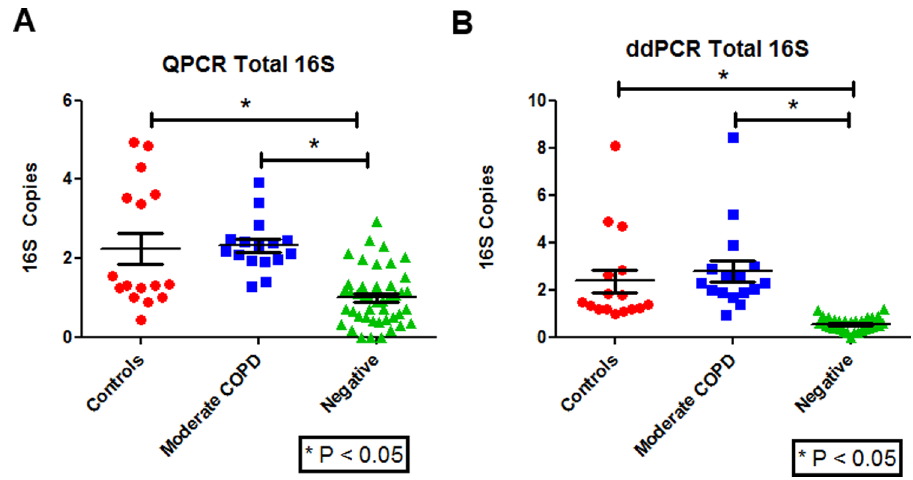
Figure 1. Overall total bacterial 16S load measured in lung tissue using qPCR or ddPCR. A) qPCR results in controls, moderate COPD, and negative non-template controls (water negative). The total bacterial 16S load was significantly lower in negative controls compared with moderate COPD and control lung tissue. B) ddPCR results in controls, moderate COPD, and negative non-template controls. The total bacterial 16S load was significantly lower in negative controls compared with moderate COPD and control lung tissue.